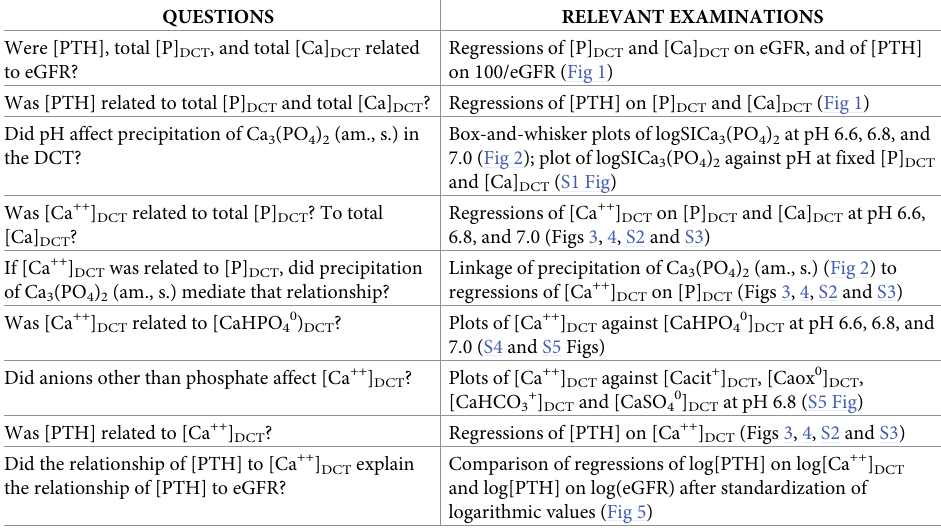
Table 1. Rationale for inquiries into the tradeoff-in-the-nephron hypothesis.